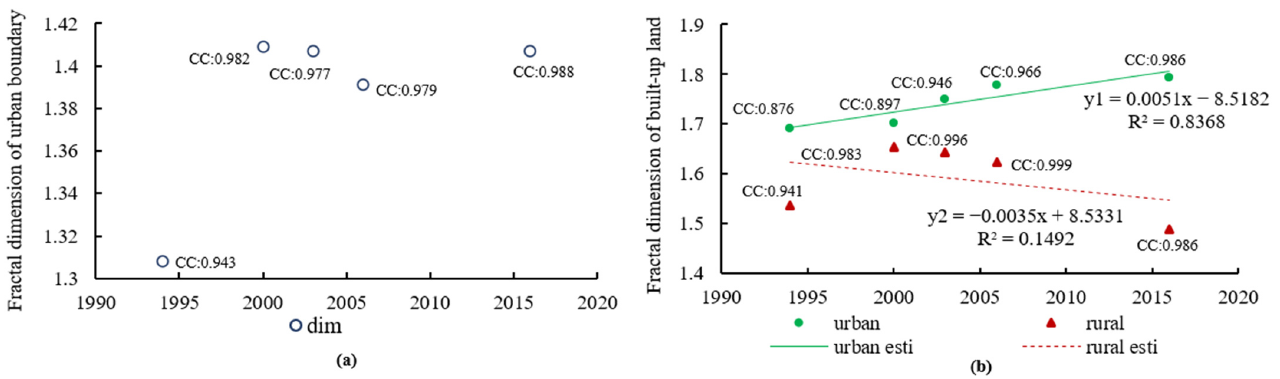
Table 7. Several indices to characterize urban and rural area. Urban Rural